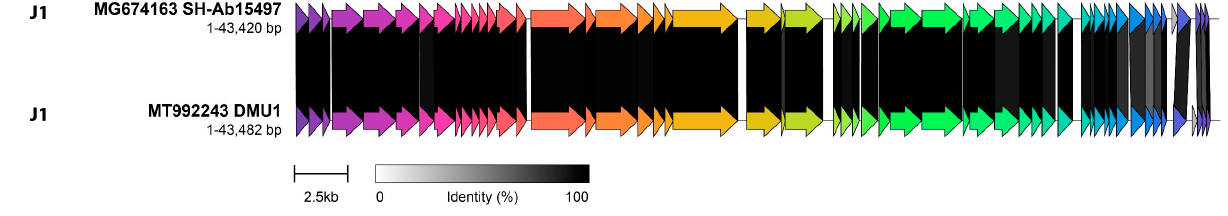
Figure 11. Comparative genome alignment of phages comprising sub-cluster J1. Phage genomes are presented alongside their designated sub-cluster, accession number, name and genome length. Coding sequences are represented by arrows, coloured to reflect homologous groups identified by Clinker, and are linked by grey bars shaded to represent the percentage amino acid identity, as indicated in the legend.